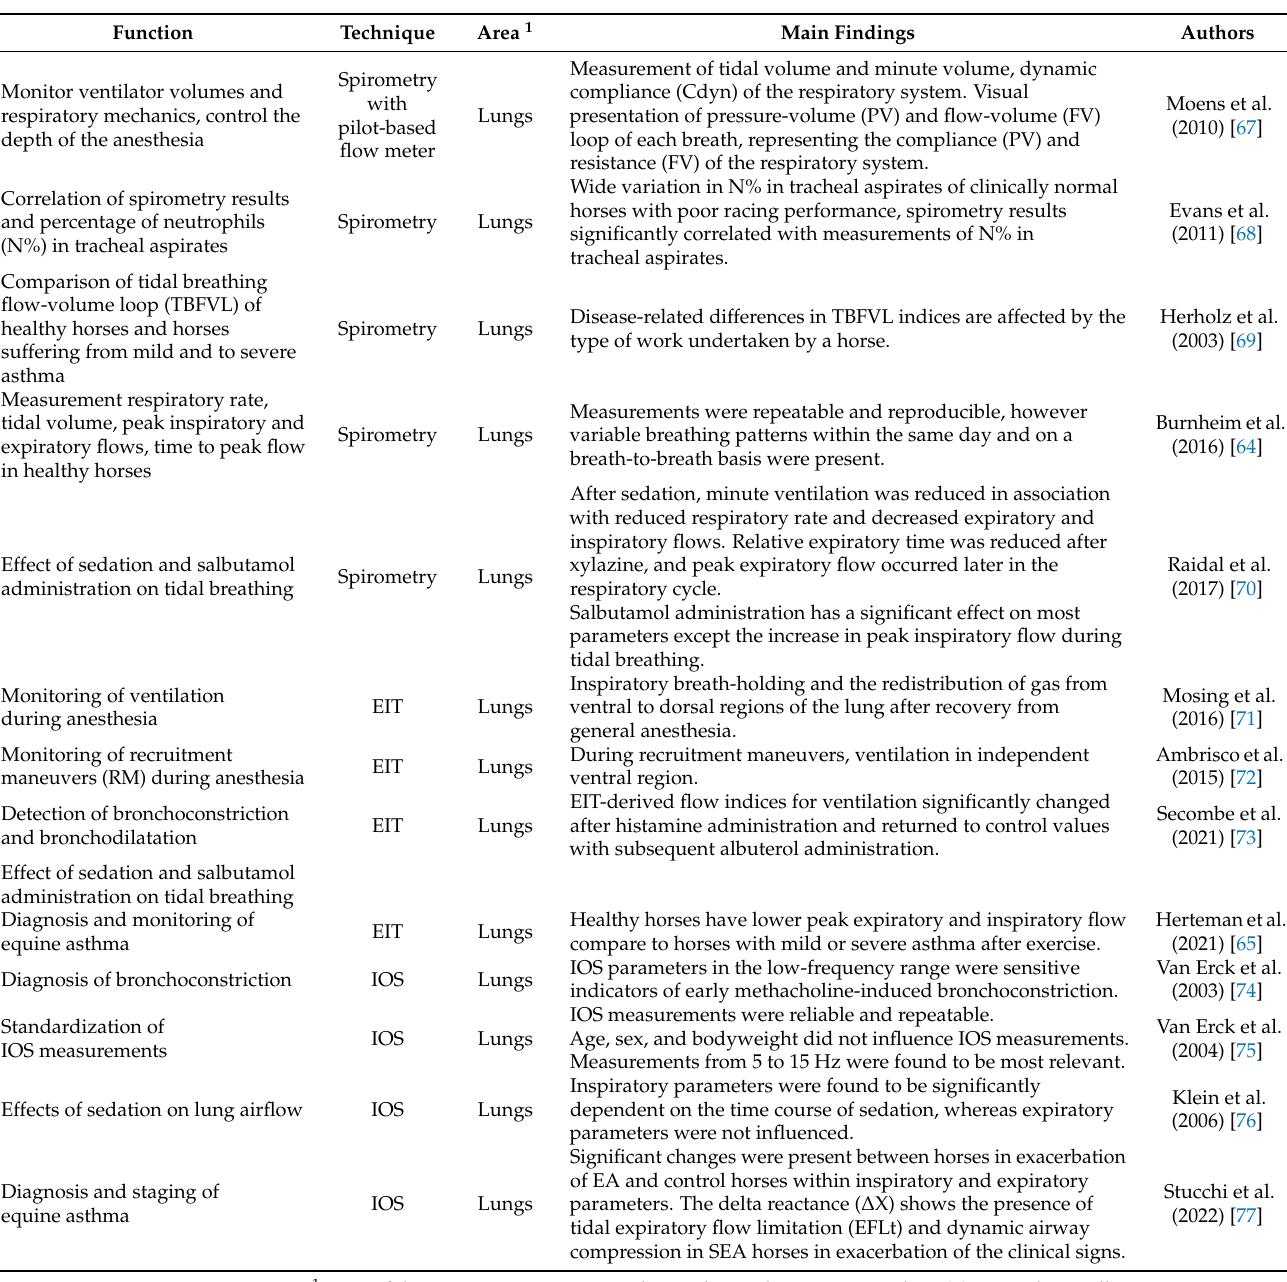
Table 3. The selected diseases of the equine lung area and their main findings diagnosed based on the consecutive pulmonary function